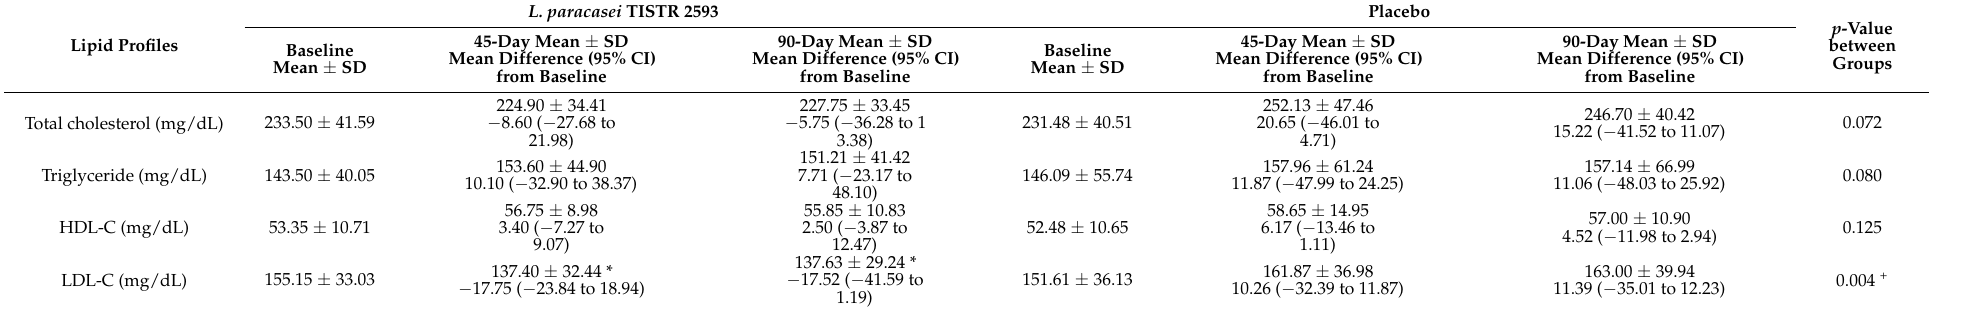
Table 3. Effect of L. paracasei TISTR 2593 supplementation on blood lipid profiles.